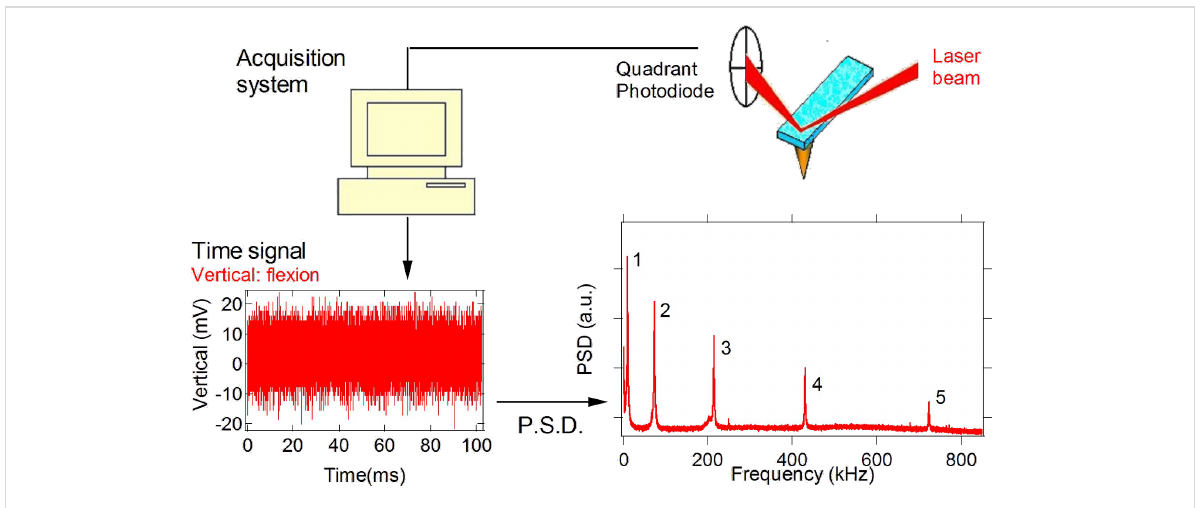
Figure 1: Block diagram of the optical beam detection system. A typical power spectral density spectrum of the cantilever flexural modes (up to the fifth) is shown.